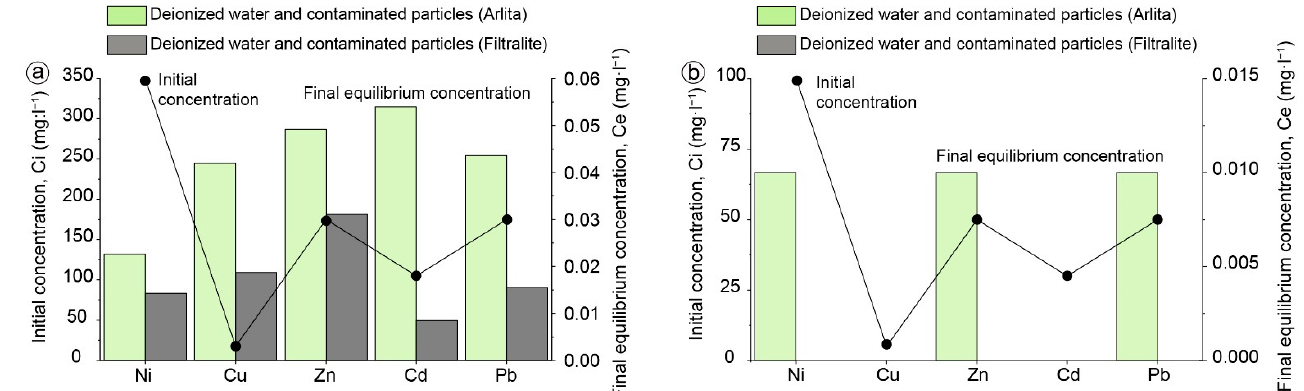
Figure 3. Final equilibrium concentration (Ce) in batch tests developed with deionized water and contaminated particles from previous batch tests performed with individual contaminated solutions ( a ) and multielemental solutions ( b ) employing the indicated initial concentration (Ci) for the different contaminants.